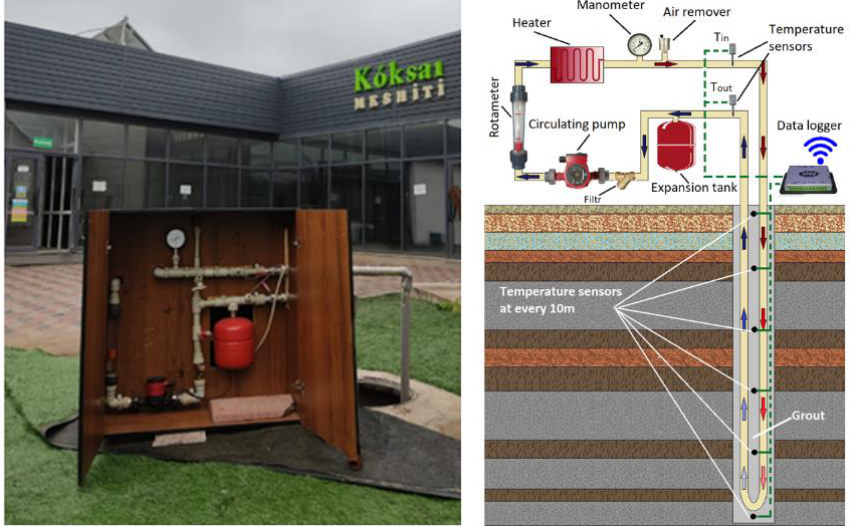
Figure 1. Thermal Response Test at Koksai mosque, Almaty.